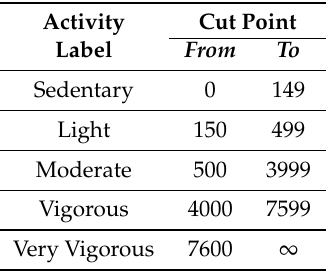
Table 1. Freedson Children ActiGraph cut